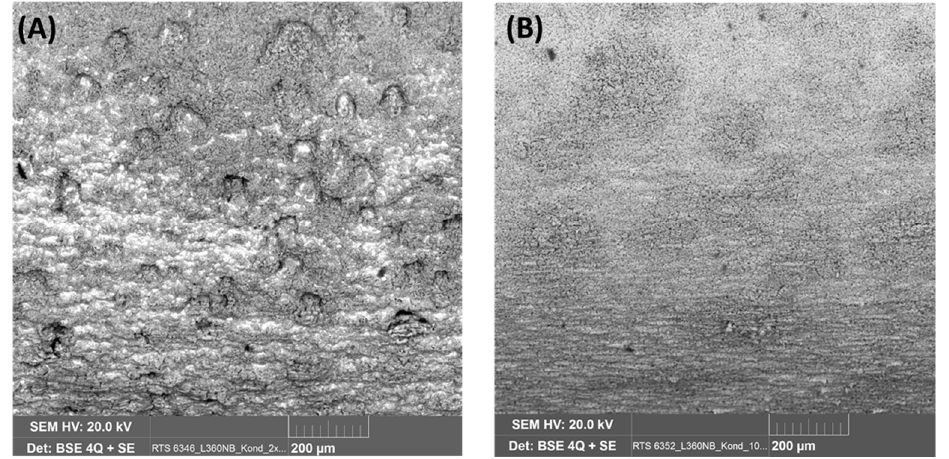
Figure 10. SEM images of L360NB exposed to the condensates containing 0.0184 M HNO 3 and ( A ) 2 times lower H 2 SO 4 concentration (57 mM), and ( B ) 10 times lower H 2 SO 4 concentration (11.4 mM).